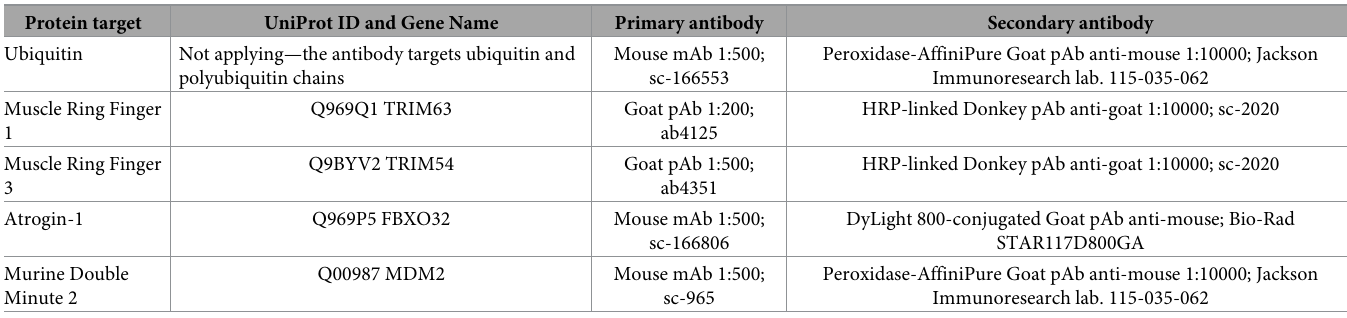
Table 2. List of antibodies used in western